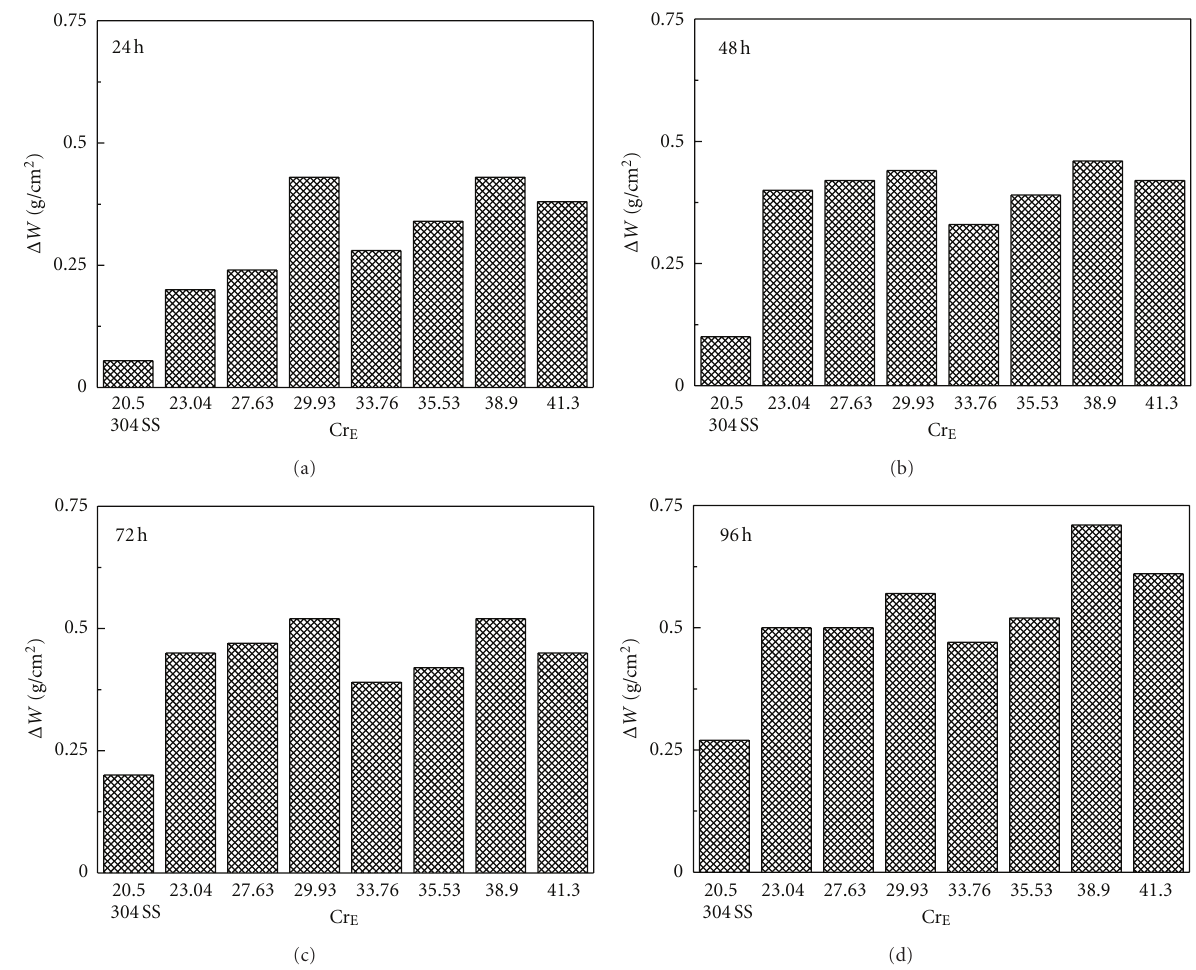
Figure 4: E ff ect of the equivalent chromium contents, Cr E , in the weight loss for the di ff erent high-chromium, high-carbon cast irons in NaCl-KCl at 670 ◦ C after di ff erent exposure times.